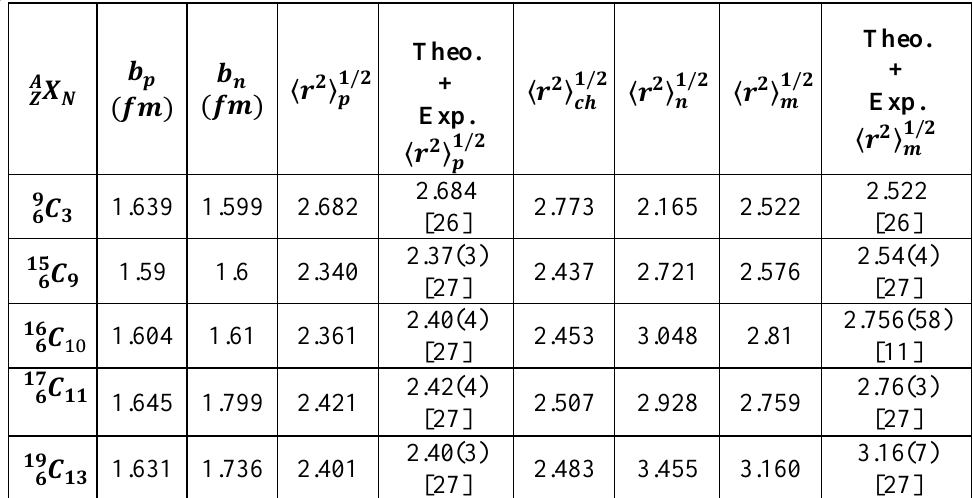
Table 5: Calculated proton, charge, neutron, matter radii in Fermi’s for Carbon isotopes 9 C, 15 C, 16 C, 17 C, 19 C by using HO+LST technique compared with available experimental data.